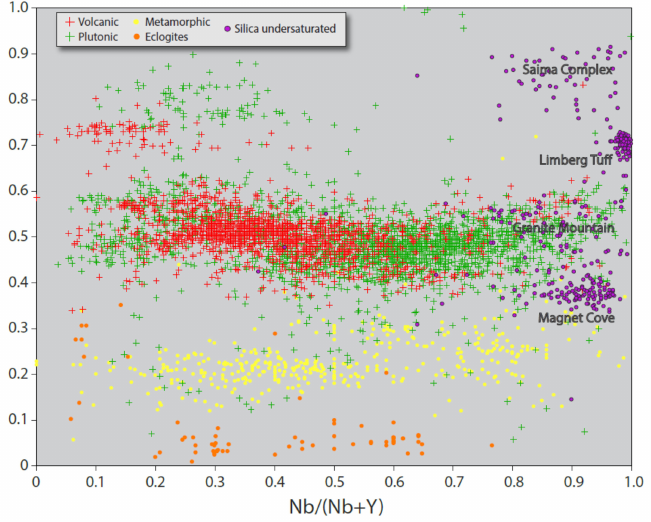
Figure 21. Fe/(Fe + Al) plotted versus Nb/(Nb + Y) for various types of titanite. Not included are anal- yses of titanite from hydrothermal, skarn, and pegmatite environments, which scatter more widely. Among the titanite analyses from silica-undersaturated rocks on Figure 21, the four main data sets for this genetic type can still be seen (as they were on Figure 20) as the four main clumps, with Magnet Cove at the lowest Fe/(Fe + Al) values (about 0.35 to 0.4), Granite Mountain at about 0.5 Fe/(Fe + Al) overlaying the end of the normal plutonic trend, the Limberg t3 Tuff at about 0.7 Fe/(Fe + Al), and the Saima alkaline complex